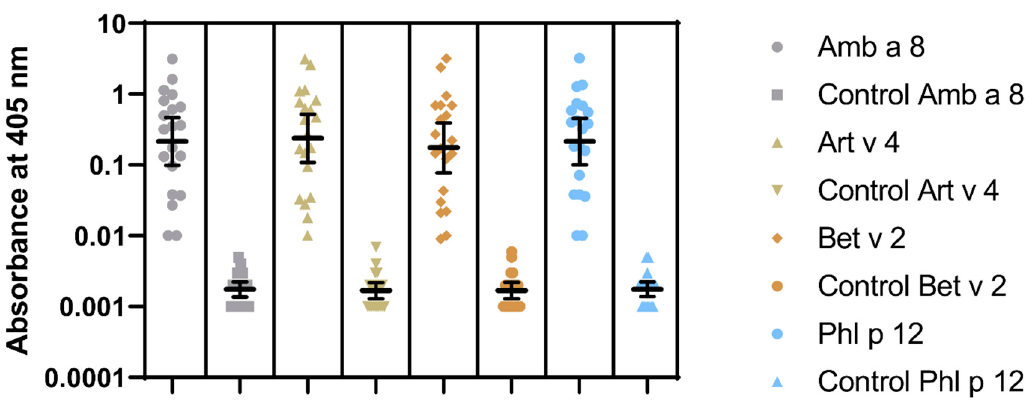
Figure 4. IgE ELISA results to recombinant Amb a 8.0101, Art v 4.0101, Bet v 2.0101, and Phl p 12.0101. Geometric means with 95% CI are marked.